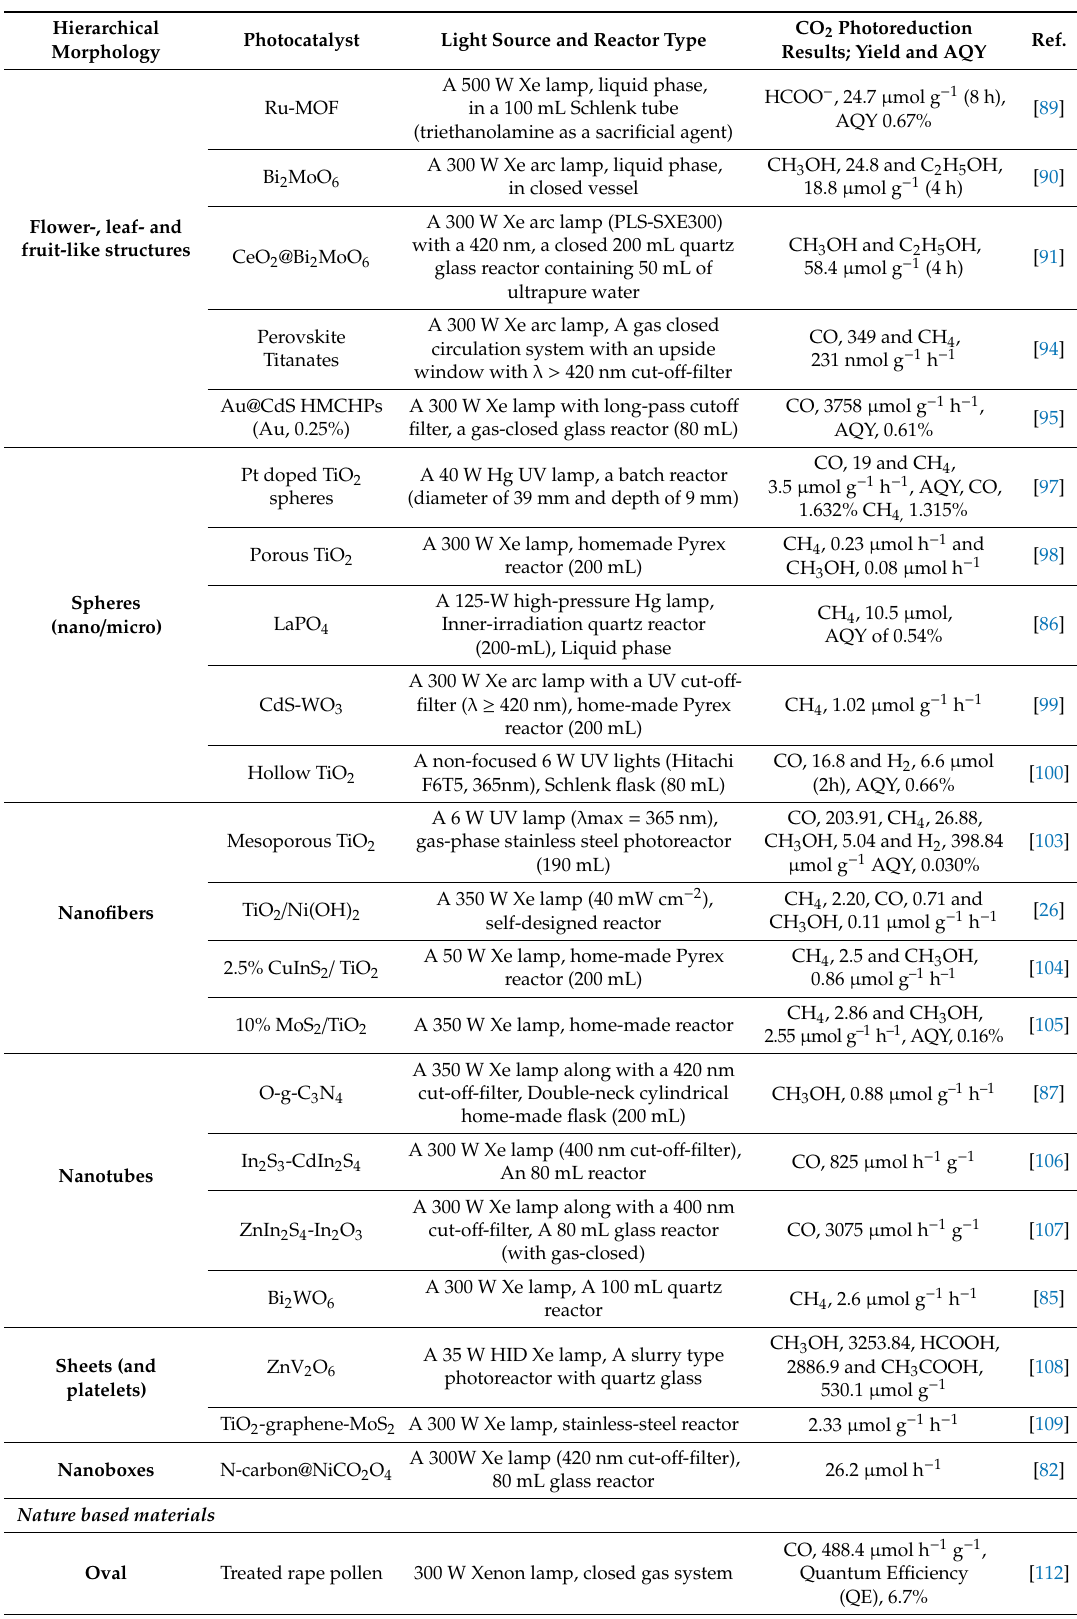
Table 2. Summary of hierarchical morphologies with specific examples of photocatalysts, CO 2 reduction parameters, and e ffi ciency evaluation of di ff erent products along with their yield and apparent quantum yield